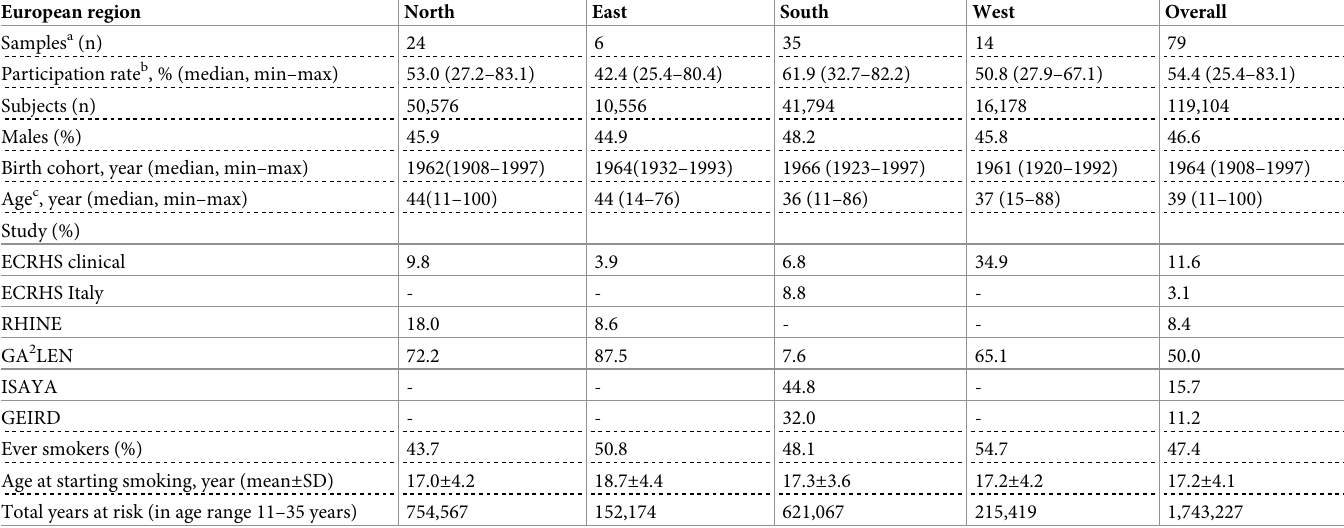
Table 1. Number of samples, participation rates, and characteristics of participants by region.